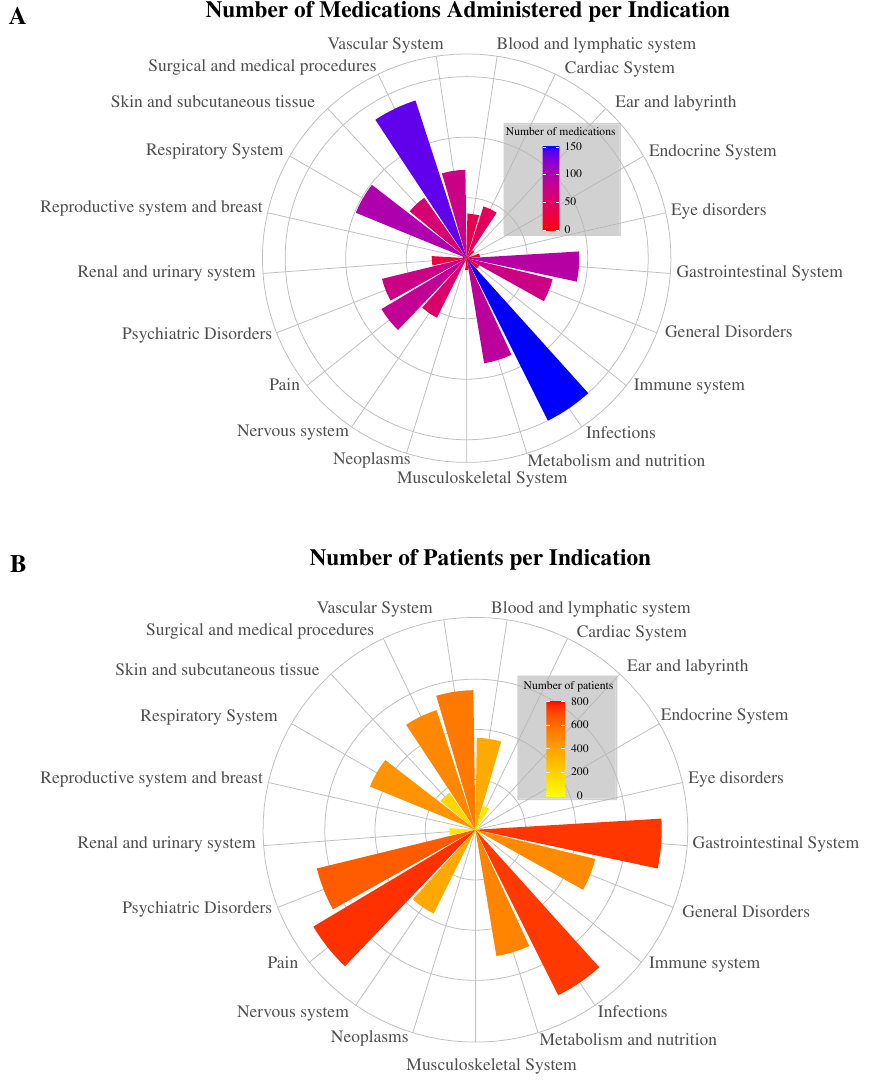
Figure 2. Indication of medications administered. ( A ) Number of unique medications administered per organ system for patients enrolled in the Sygen clinical trial. Note the diversity of medications administered within each category of complications. For instance, over 100 different medications were administered to treat infections and infestations as well as for surgical and medical procedures. ( B ) Number of patients of the Sygen clinical trial that required treatment per organ system. The three most frequently treated secondary complications were pain, gastro-intestinal system disorders, as well as infections. The SCIRehab database did not track the indications for which medications were